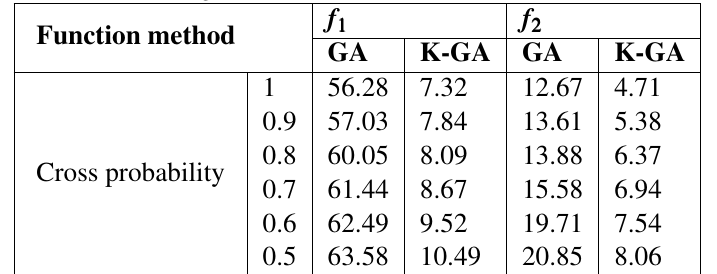
Table 1 Algorithm simulation results of test